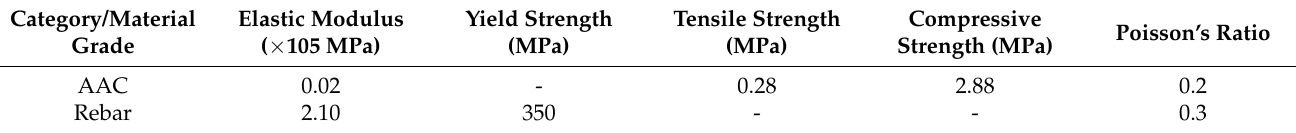
0 Figure 14. Mesh analyses results for the AACP. Figure 14. Mesh analyses results for the AACP.